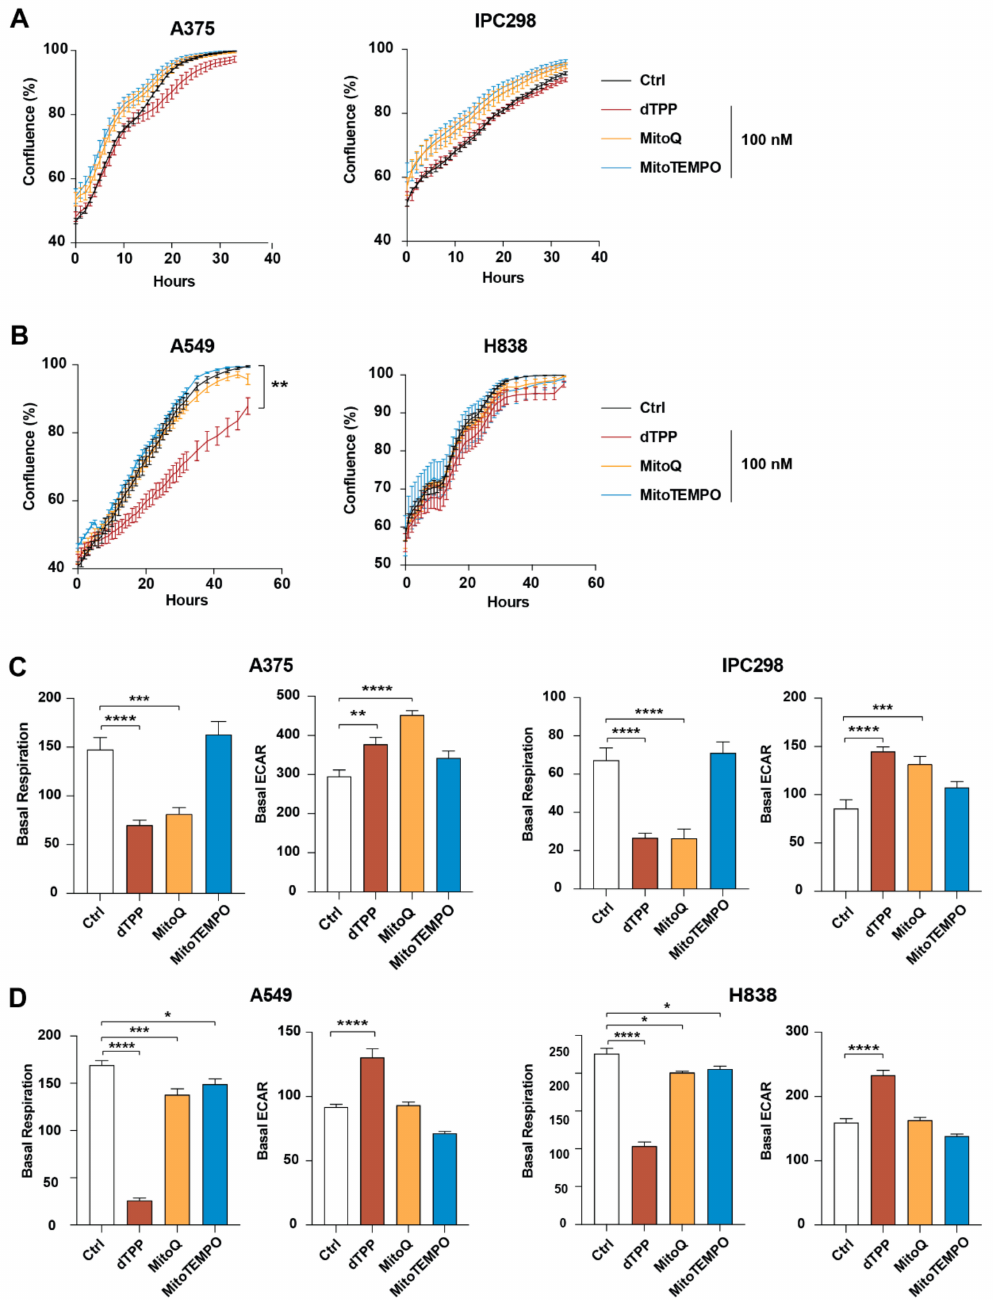
Figure 4. Mitochondria-targeted antioxidants have minimal effects on cell proliferation and inconsistent effects on metabolic parameters in vitro. ( A ) Proliferation of human malignant melanoma cell lines A375 and IPC298 incubated with the indicated compounds in an Incucyte Live-Cell Imaging system. Note Y -axis scale. ( B ) Proliferation of human lung cancer cell lines A549 and H838 incubated with the indicated compounds in an Incucyte live-cell imaging system. Note Y -axis scale. ( C ) Basal mitochondrial respiration and extracellular acidification rate (ECAR) of A375 and IPC298 melanoma cell lines. ( D ) Basal mitochondrial respiration and extracellular acidification rate (ECAR) of A549 and H838 lung cancer cell lines. * p < 0.05; ** p < 0.01; *** p < 0.001; **** p <